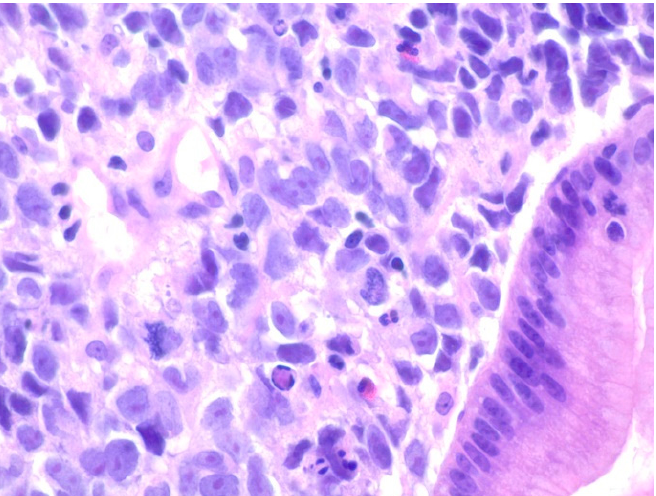
Figure 16. Hematoxylin and eosin-stained section showing pleomorphic cells with prominent nu- cleoli with intranuclear cytoplasmic pseudoinclusion and atypical mitosis suggestive of malignant melanoma in a background of gastric foveolar epithelium at 600× magnification. A 76-year-old with multiple medical comorbidities presented with melena for which endosocpic evaluation was requested. Imaging had revealed concerns for diffuse hepatic metastases in addition to bone metastases with large right perihilar mass with bilateral pulmonary nodules, mediastinal adenopathy and right sided pleural effusion. EGD showed several cratered gastric body ulcers a few of them actively oozing (Figure 17). Hemostasis achieved with bipolar coagulation and biopsies obtained from non-bleeding ulcers. Pathology revealed metastatic poorly differentiated neuroendocrine carcinoma consistent with small cell carcinoma (Figure 18).